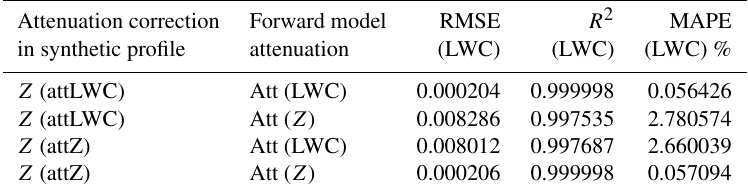
Table 5. Variation in a priori error and different errors calculated with respect to true